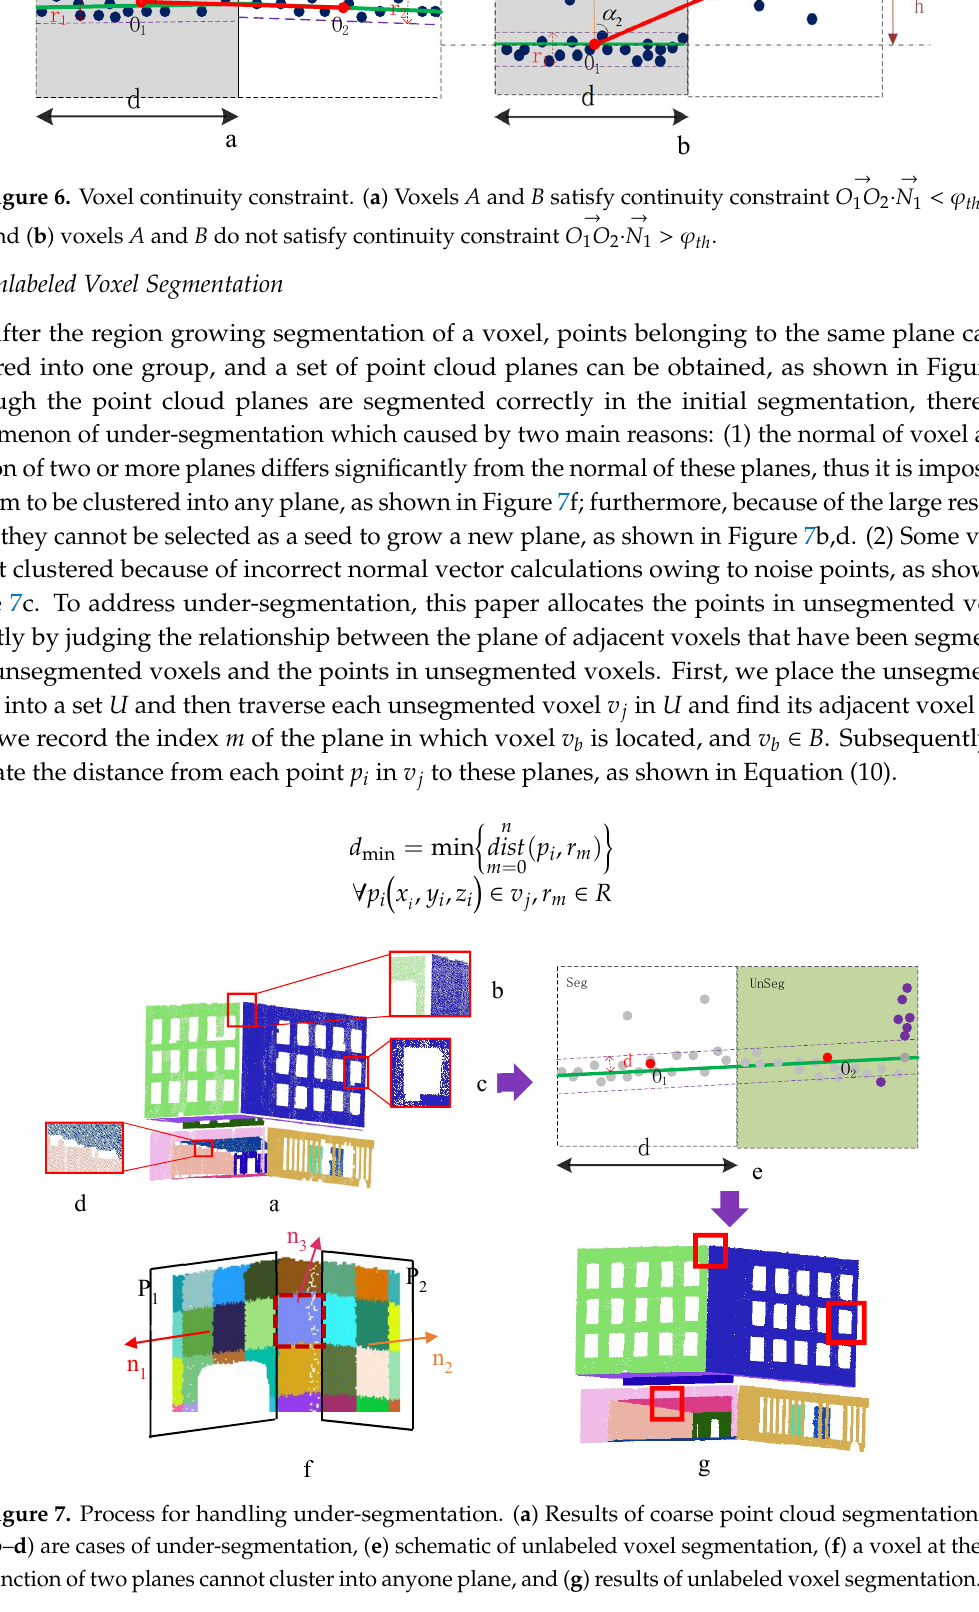
Figure 6. Voxel continuity constraint. ( a ) Voxels A and B satisfy continuity constraint 1 2 1 th OO N and ( b ) voxels A and B do not satisfy continuity constraint 1 2 th OO N